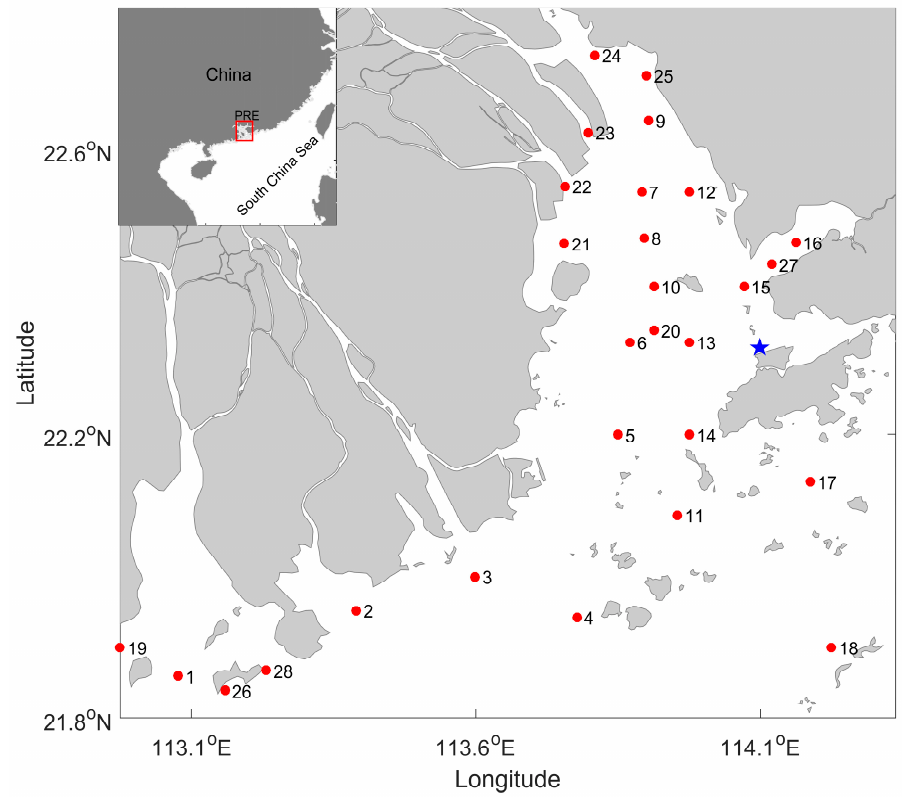
Figure 1. Enlarged view of the Pearl River estuary (PRE) with an indication of the geographic location. The red dots represent the stations where the ichthyoplankton data were collected. The blue start represents the long ‐ term monitoring site of the Hong Kong EPD.